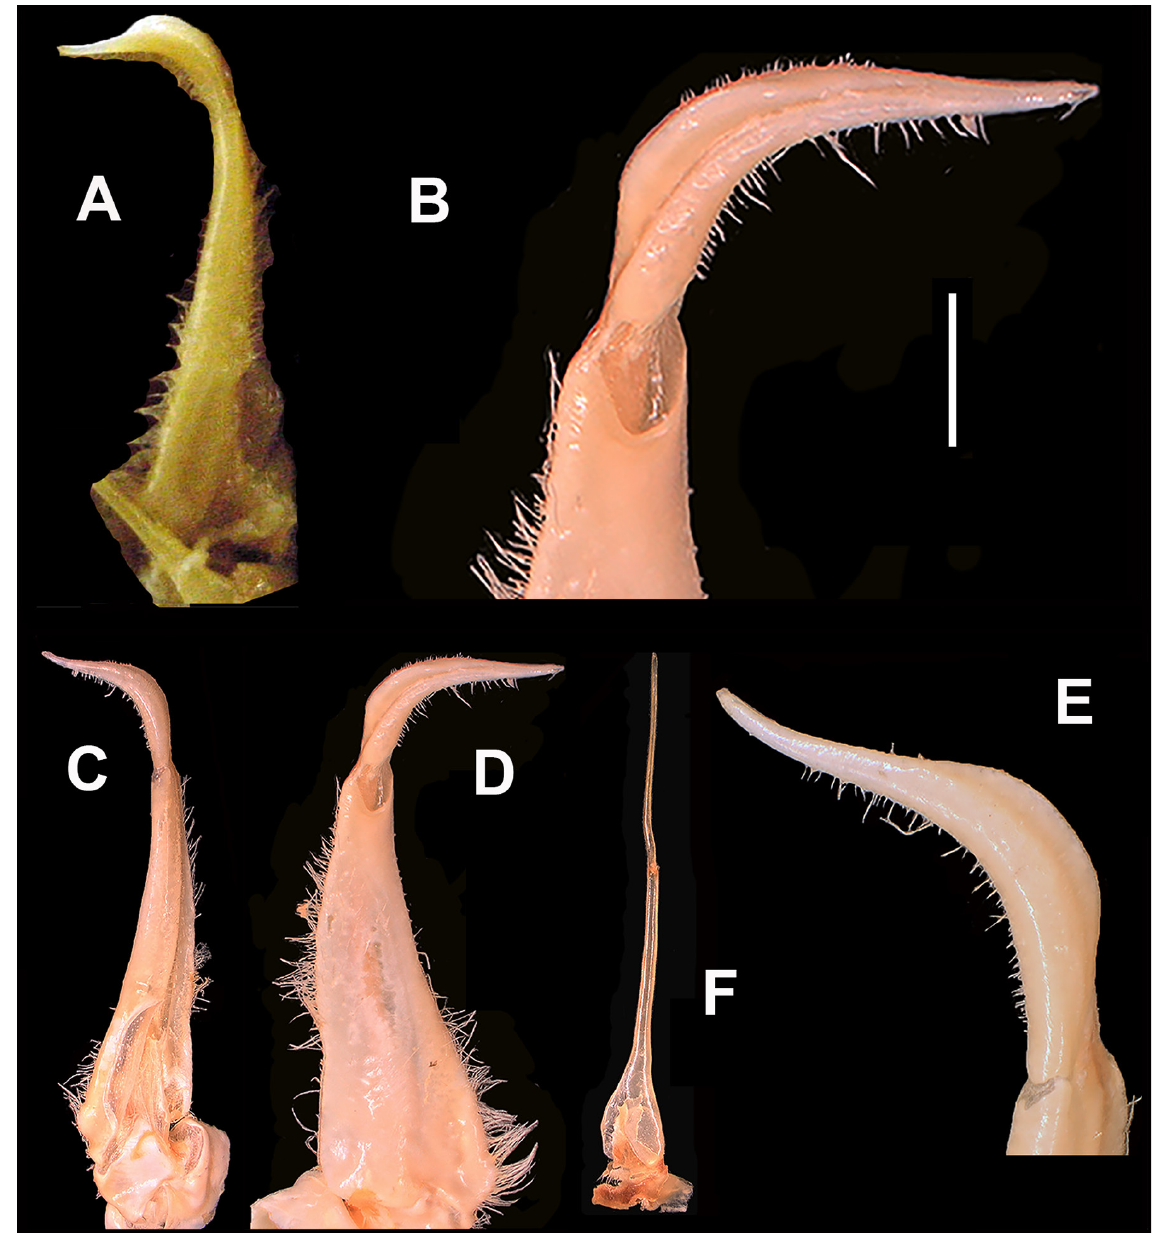
Fig. 11. A. Potamonautes kisangani sp. nov., holotype, adult, ♂, CW 60.5 mm, from Kisangani, Democratic Republic of the Congo (USNM 98944). G1, ventral view. – B–F . P. amosae sp. nov., holotype, adult, ♂, CW 46.5 mm, from Lake Kivu, D.R. Congo (NHMUK 2018.306). C, E . G1, ventral view. B, D . G1, dorsal view. F . G2, ventral view. Scale bar: A, C–D = 3.0 mm; B = 3.1 mm; E = 1.2 mm; F = 1.3